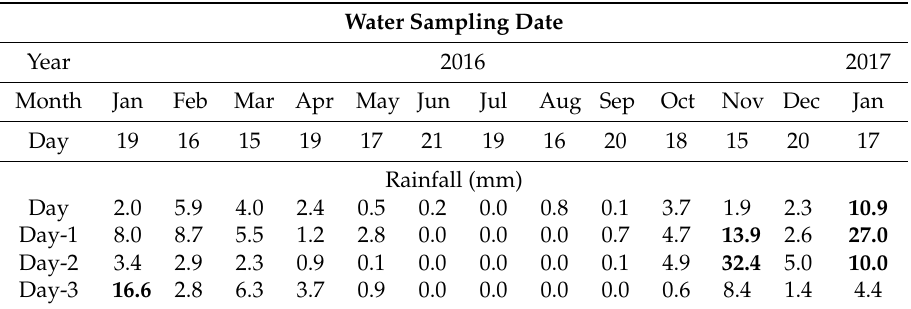
Table 1. Weather conditions (rainfall) in the water sampling day and the three antecedent days (day-1 until day-3). Values larger than 10 mm day − 1 are represented in